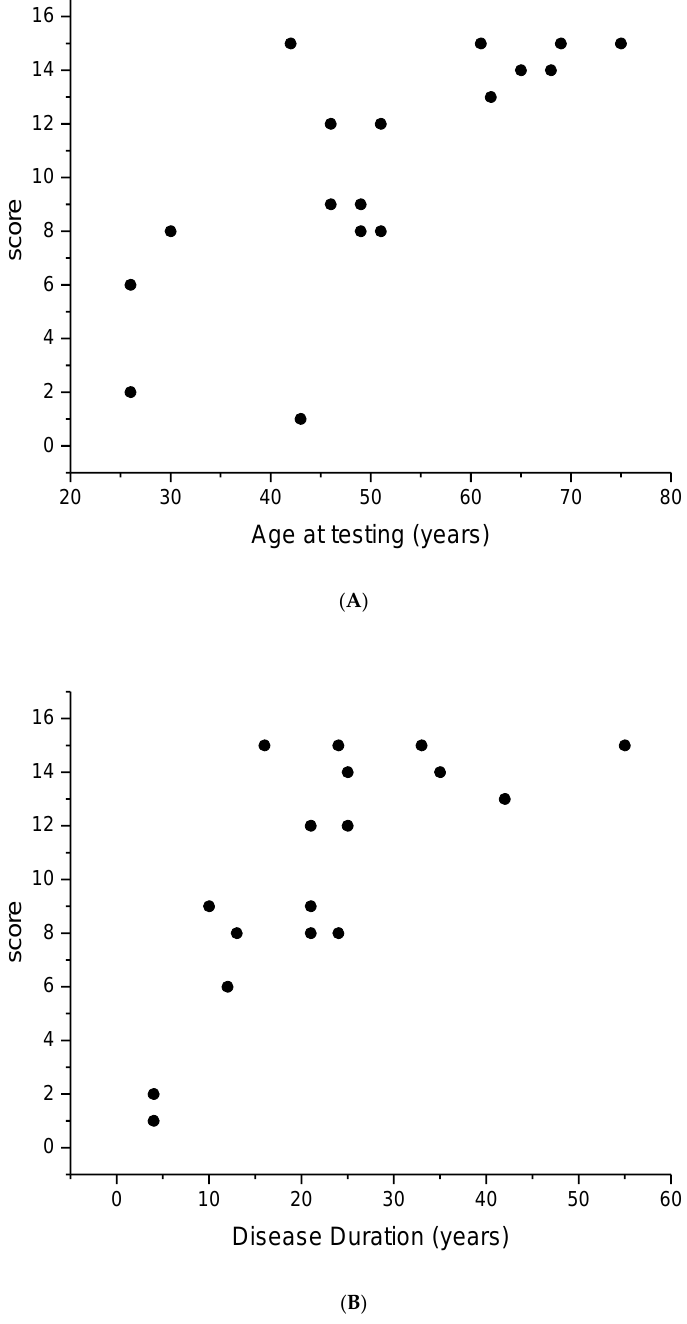
Figure 2. Cumulative score (CS) from the right eye of each EYS patient plotted as a function of age at testing ( A ) and disease duration ( B ). It can be noted that the score increases linearly with both parameters. The r value is 0.54 ( p <